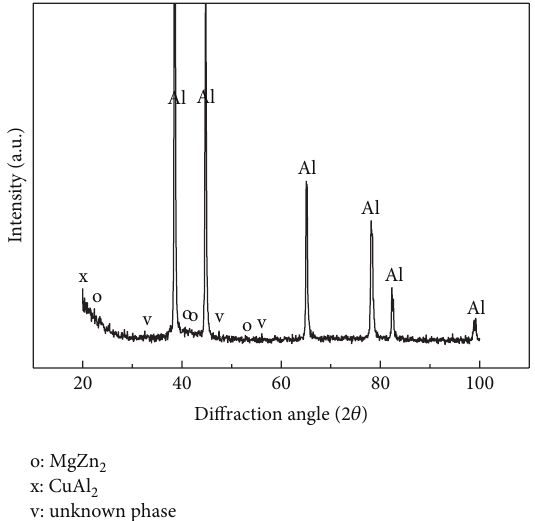
Figure 8: X-ray diffraction pattern of Alumix 431D after T6 heat treatment.